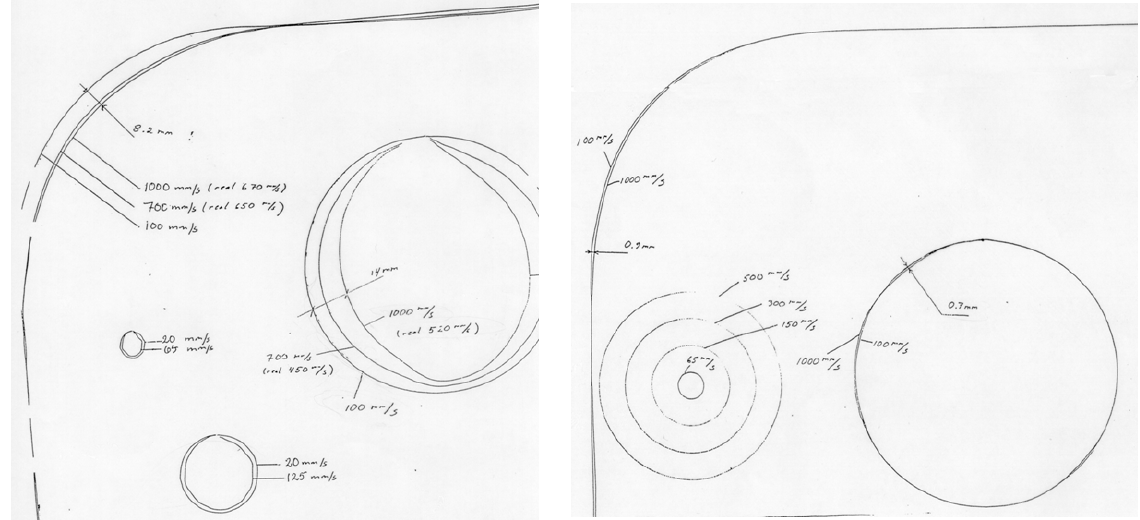
Figure 2: Registrations of robot paths at different speeds with (to the right) and without model-based control. The registrations were made in 1994 when ABB introduced the S4 controller with full model-based control (marketed as QuickMove and TrueMove). The model-based control in this case reduced the maximum path errors with a factor of